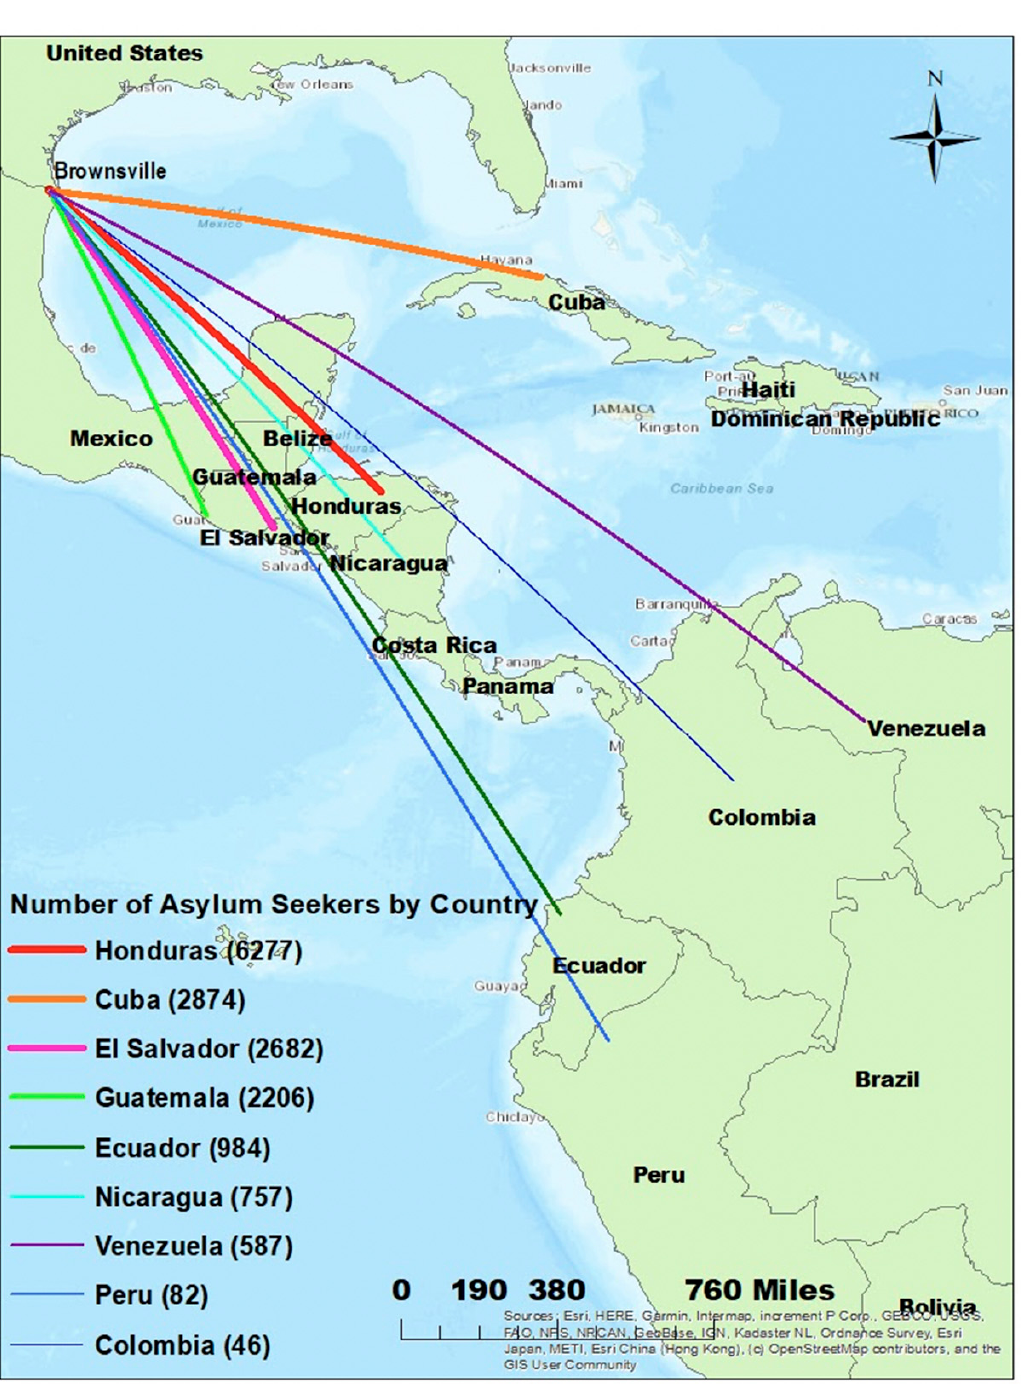
Figure 2. Number of asylum seekers by country processed into the MPP program at the Brownsville–Matamoros border. Data source: Syracuse University (2020).